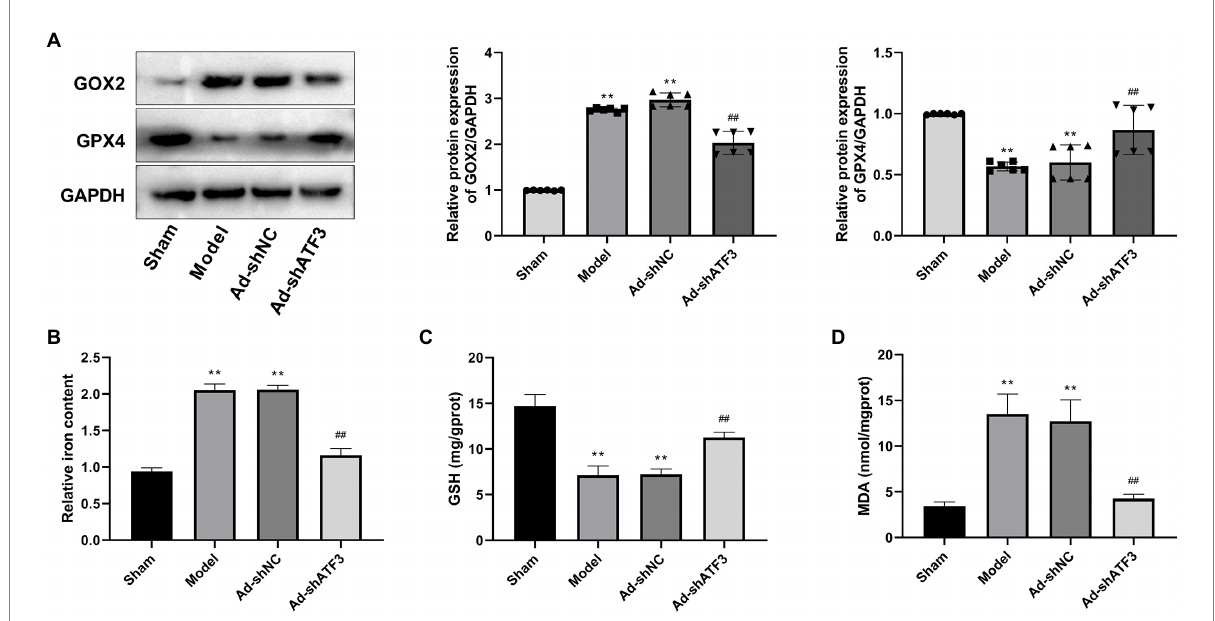
FIGURE 5 Knockdown of ATF3 inhibited ferroptosis in IS rats ( N = 6 each group). (A) Western blot analysis of GOX2 and GPX4 expression at the protein level. (B) Iron content. (C) GSH content. (D) MDA content. ** p < 0.01 vs. Sham; ## p < 0.01 vs.